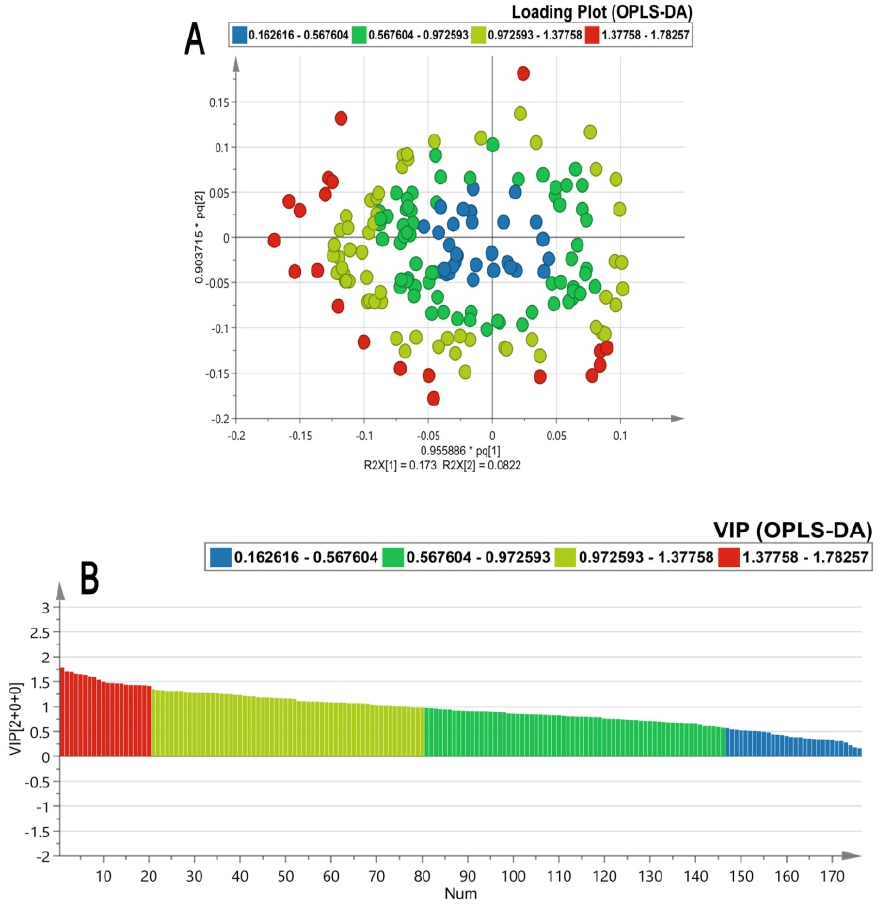
Figure 4. Discriminant serum metabolite extraction by ( A ) loading and ( B ) VIP plot (OPLS-DA) having VIP having VIP >1.3.